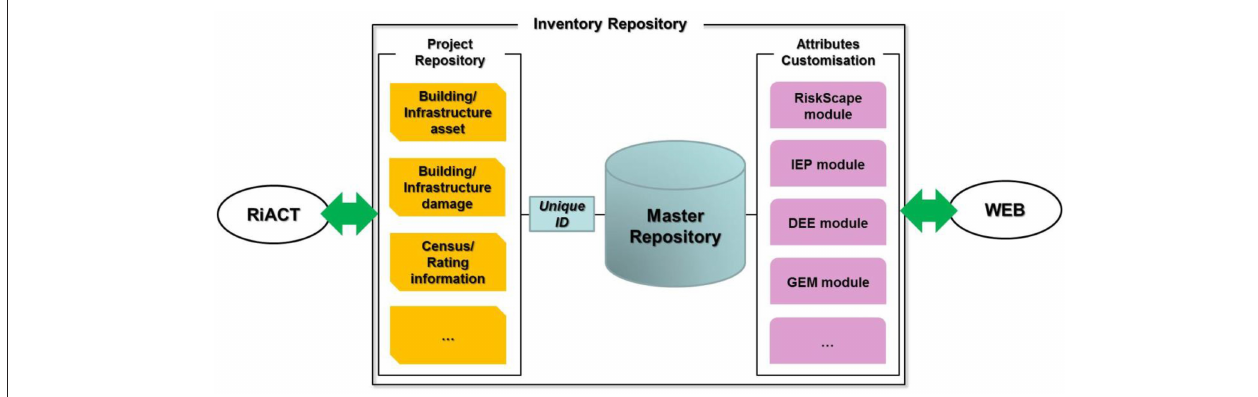
FIGURE 2 | Inventory Repository